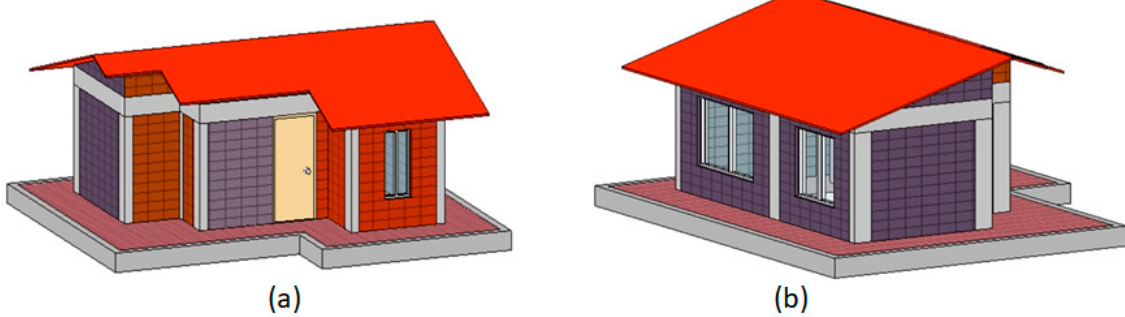
Figure 5. Architectural design (virtual modeling) of the eco-house prototype: ( a ) front view and ( b ) rear view.